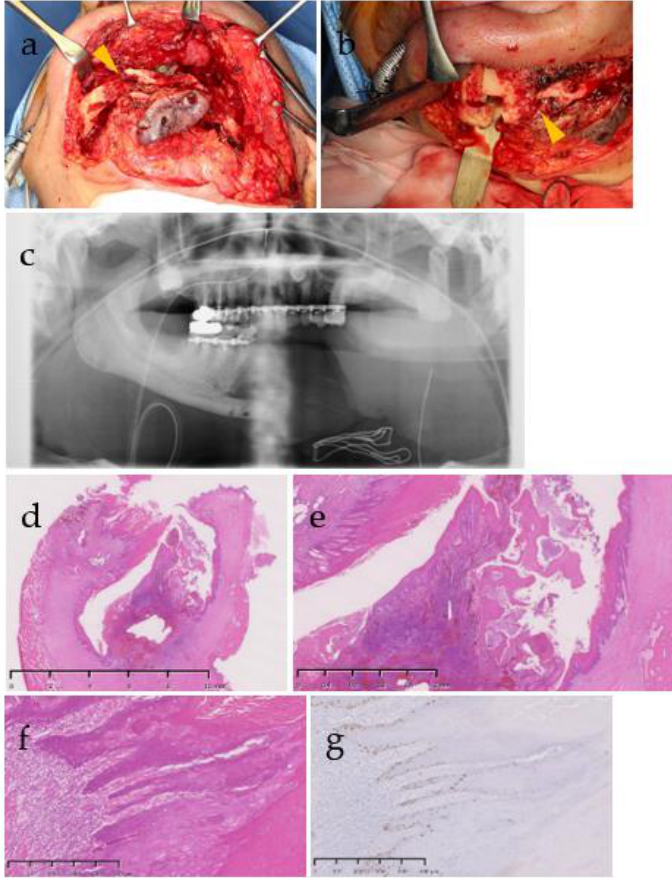
Figure 6. ( a , b ) Intra-operative images of mandibular resection, ( c ) panorama X-P after the mandibular resection, and ( d – g ) photomicrograph of mandibular segment resection. Yellow arrowheads indicate pathological fractures ( a , b ). Invagination of the stratified squamous epithelium was observed in the mandible ( d ) and the epithelium was observed along the rotting bone ( e ), but epithelial atypia was scarce ( f ) and about 14% of Ki-67-positive cells were relatively localized in the basal layer and parabasal layer ( g ). There were a few findings to diagnose a neoplastic lesion, and osteomyelitis was considered to have spread from peri-implantitis. Stain, hematoxylin and eosin (H&E) ( a – c ), ki-67 immunohistochemistry staining ( e ); magnification, original × 5 ( b ), 20 ( c ), 100 ( d , e